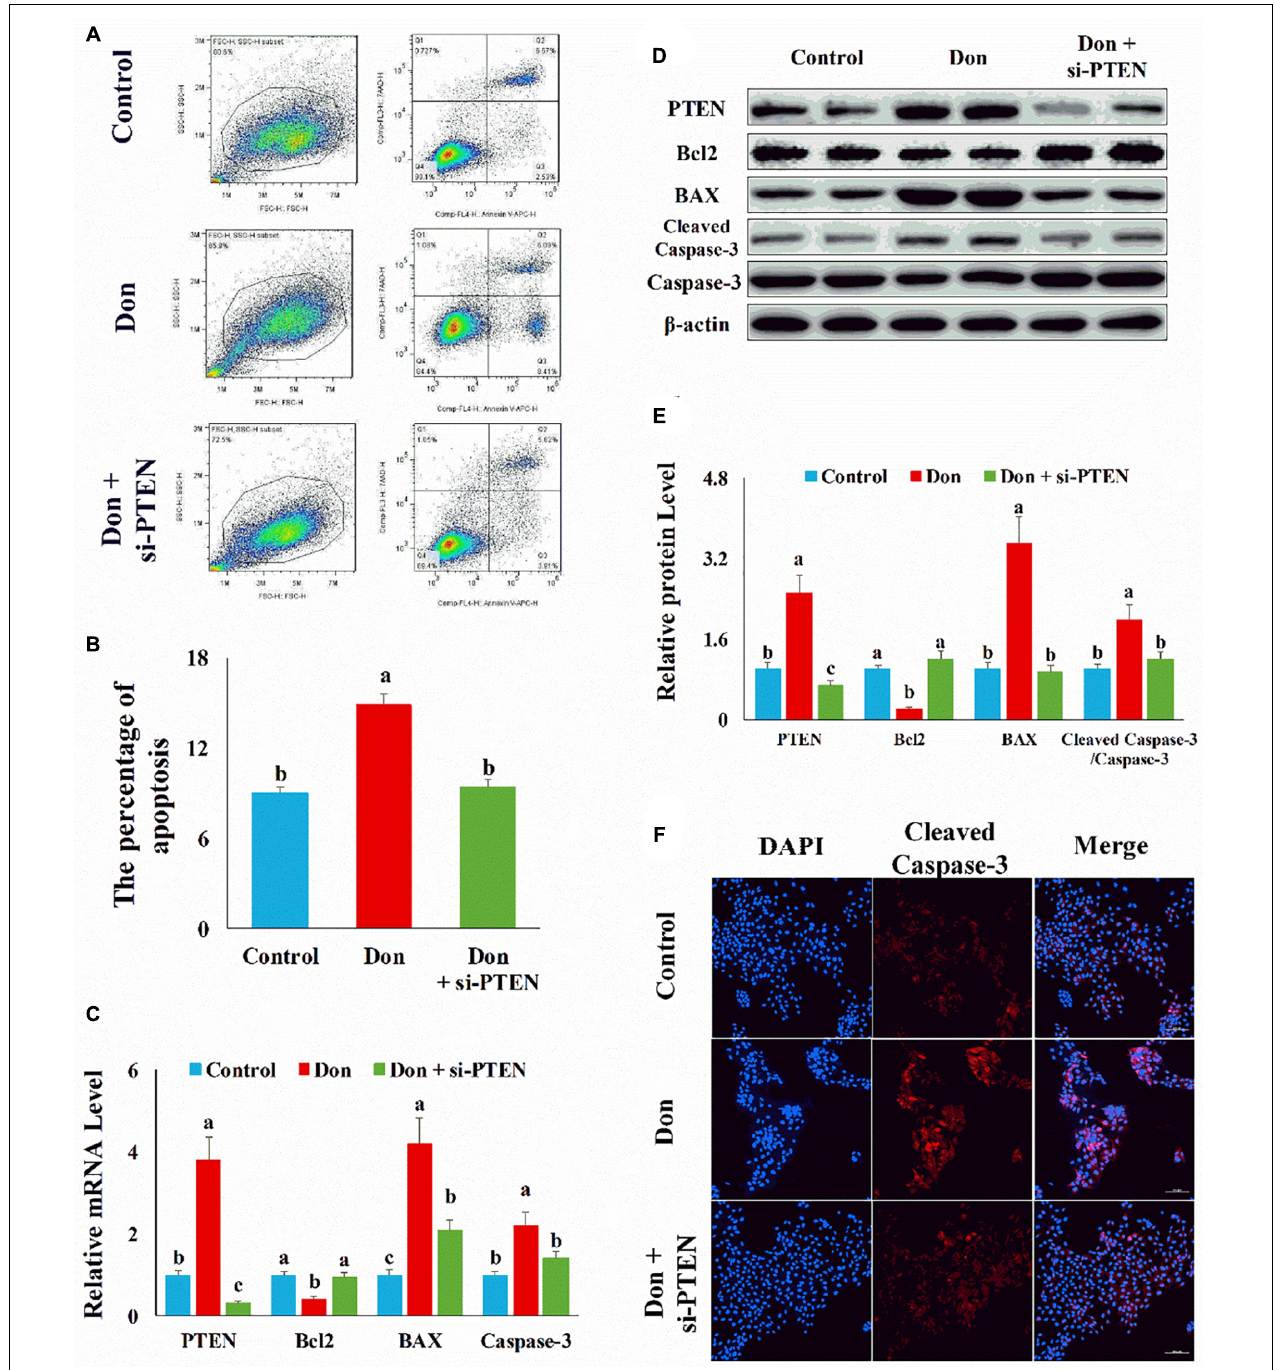
FIGURE 6 | Don-induced apoptosis in intestinal epithelial cells relied on PTEN. (A) Representative images of apoptosis assay for intestinal epithelial cells by using the apoptosis detection kit. Cells localized in Q4 displayed Annexin V-APC-negative/7AAD-negative viable cells. The cells gated in Q2 and Q3 quadrant displayed Annexin V-APC-positive apoptotic cells. (B) The quantitative result of (A) . (C) qPCR results indicated that Don-induced apoptosis in intestinal epithelial cells relied on PTEN. (D) Western blot results showed Don-induced apoptosis in intestinal epithelial cells relied on PTEN. (E) The relative protein levels obtained by WB band gray scanning. (F) Representative images of the caspase-3 immunofluorescent staining for apoptotic intestinal epithelial cells. Cleaved caspase-3: red, a molecular marker of apoptosis; DAPI: blue, cell nucleus; Merge: the apoptotic cells. Our results were presented as mean ± SEM of triplicate independent experiments for each group. Bars with different letters indicate they are significantly different ( p < 0.05). In (F) , magnification = × 100; the scale bar on the photomicrographs represents 100 µ m. Don, IPEC-J2 cells were exposed to 1.6 µ g/ml Don for 12 h. Don + si-PTEN, IPEC-J2 cells were transfected with 80 nM si-PTEN mimics for 24 h, then exposed to 1.6 µ g/ml Don for 12